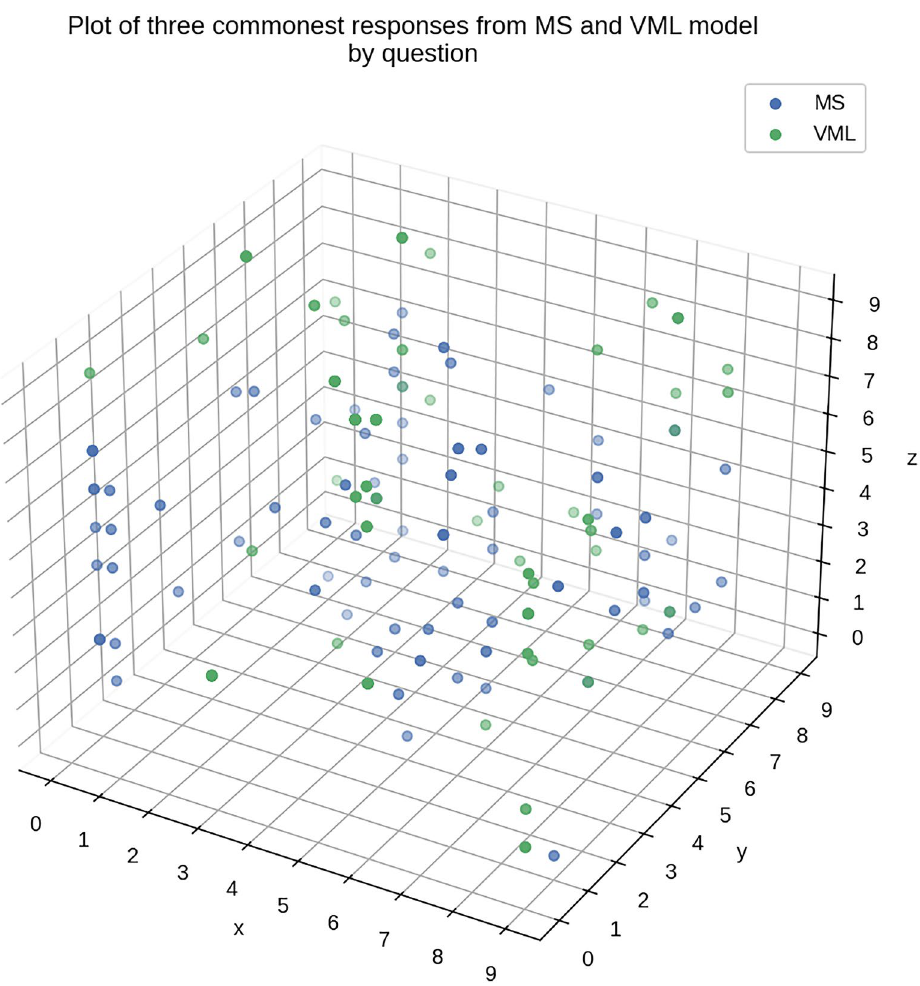
Figure 12. Plot of three commonest responses from MS and VML. Each dot represents a question from the quiz. The x axis represents the commonest response, y axis – the second commonest, and z axis – the third commonest response, from medical students on that question (in blue). For VML model (in green), the x axis is the prediction with highest probability, y axis – second highest and z-axis, third highest probability. The numbers 0 to 9 on each axis represent the 10 categories of tissue: ’cerebellum’, ’cerebrum’, ’heart’, ’kidney’, ’liver’, ’lung’, ’pancreas’, ’skin’, ’stomach’, & ’trachea’ . The quiz consisted of 100 questions ( n = 100) (Figure generated by Matplotlib python library, version 3.3.4, https:// matpl otlib.